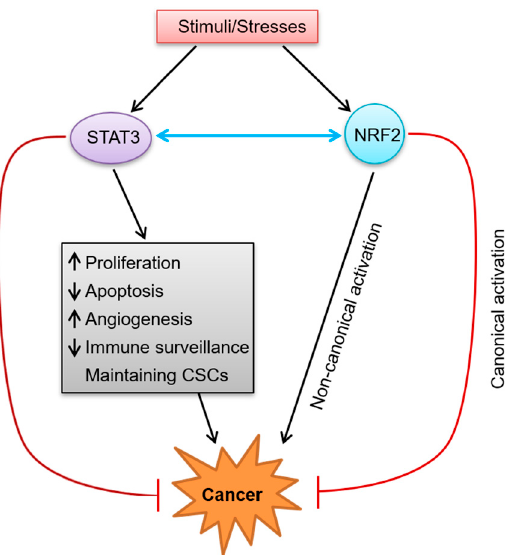
Figure 2. The dual roles of STAT3 and NRF2 in cancer and their crosstalk. When cells are stimulated by various kinds of stimuli/stresses, STAT3 and NRF2 will be activated. Activated STAT3 promotes cancer development through multiple mechanisms including promoting cell proliferation, suppressing apoptosis, facilitating angiogenesis, escaping immune surveillance, and maintaining CSCs. On the other hand, activated STAT3 has anti-tumor function. Just as STAT3, NRF2 can not only promote carcinogenesis via a non-canonical activation mode, but also inhibit the development of cancer through a canonical mode. In addition, STAT3 and NRF2 can also interact with each other. (The black arrow represents activation, the red arrow represents inhibition, and the blue double- head arrow represents interaction/crosstalk.).